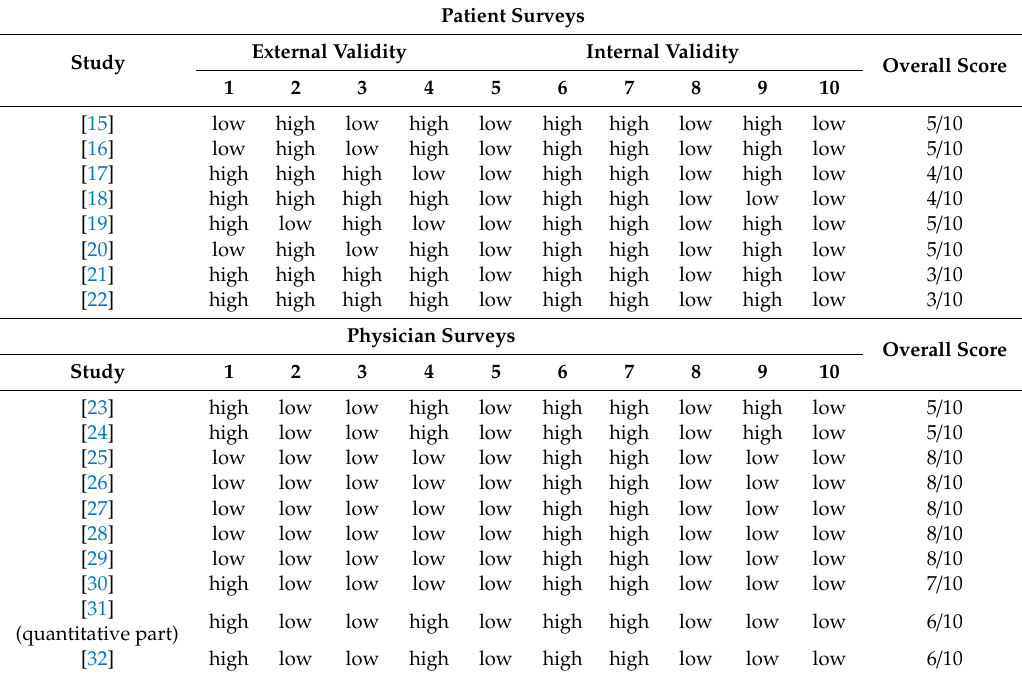
Table 3. Assessment of risk of bias in quantitative